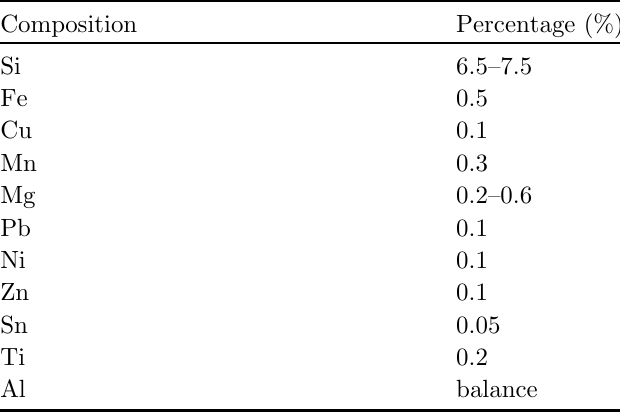
Table 1. Chemical composition of LM25 (in weight %).